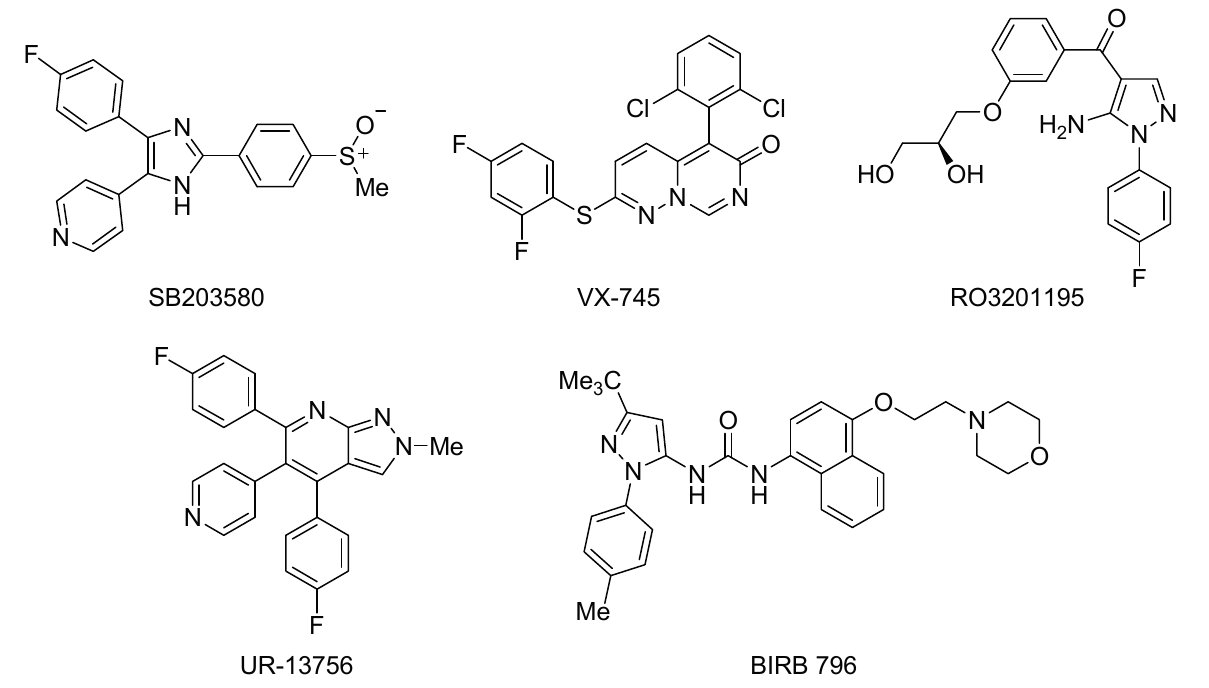
Figure 1. Inhibitors of p38 MAPK examined in WS